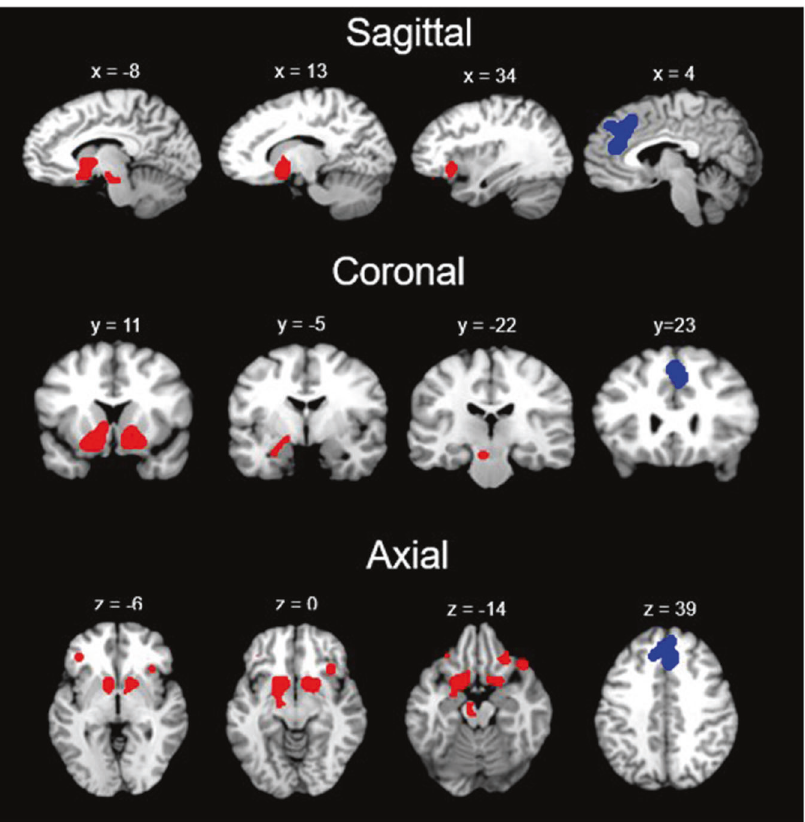
Fig. 3 Concordant connectivity across SUD and BA. Concordant hyperconnectivity (red) and hypoconnectivity (blue) across SUD and BA (Sagittal, Coronal and Axial views).